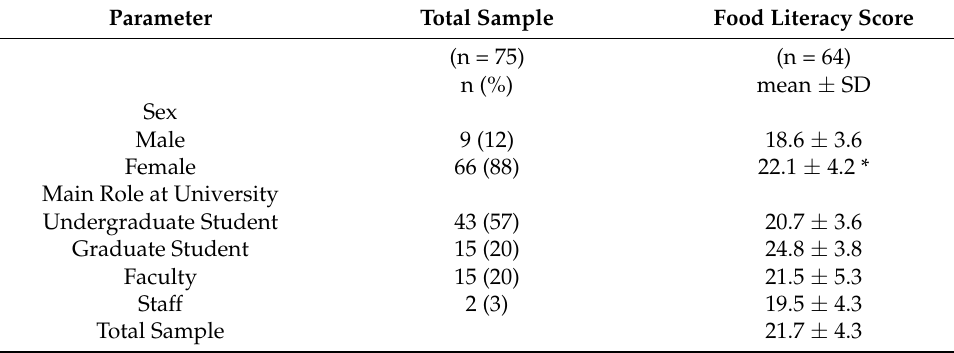
Table 1. Food literacy scores by sex and campus